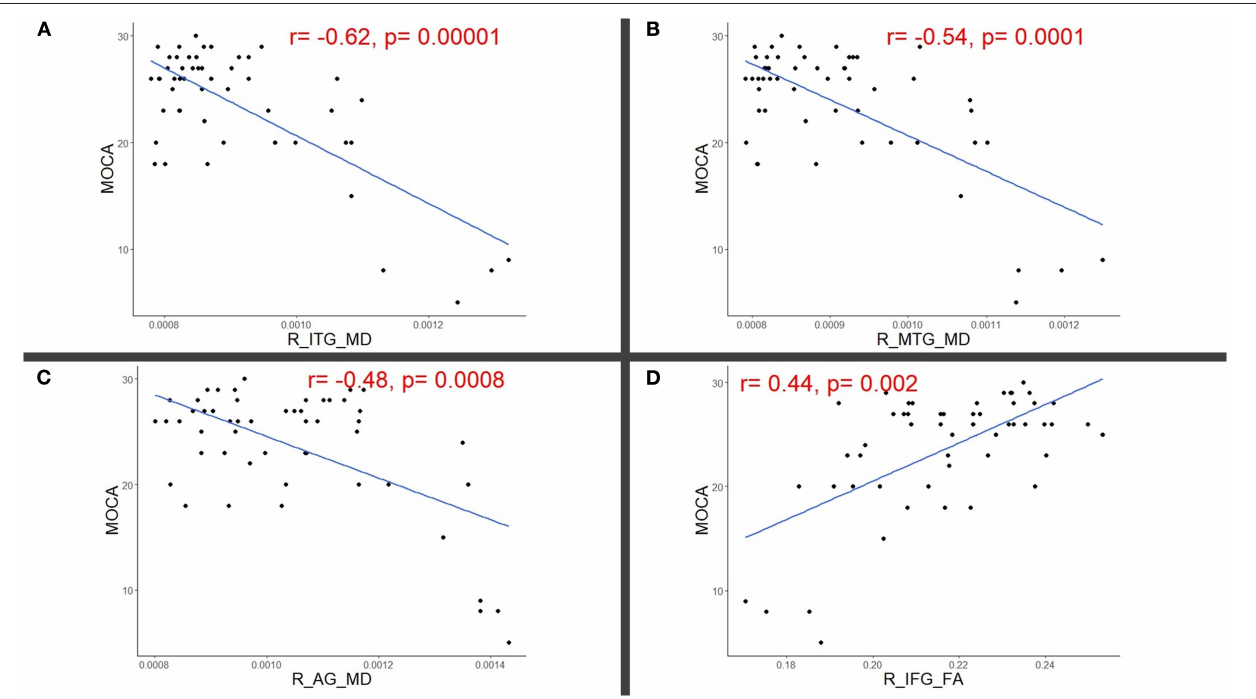
FIGURE 1 | Scatter plots illustrating significant partial correlations (adjusted for age and lesion load) between Montreal cognitive assessment (MoCA) and right (R) (A) Inferior temporal (ITG), (B) Middle temporal (MTG), (C) Angular (AG), and (D) Inferior frontal gyri (IFG).